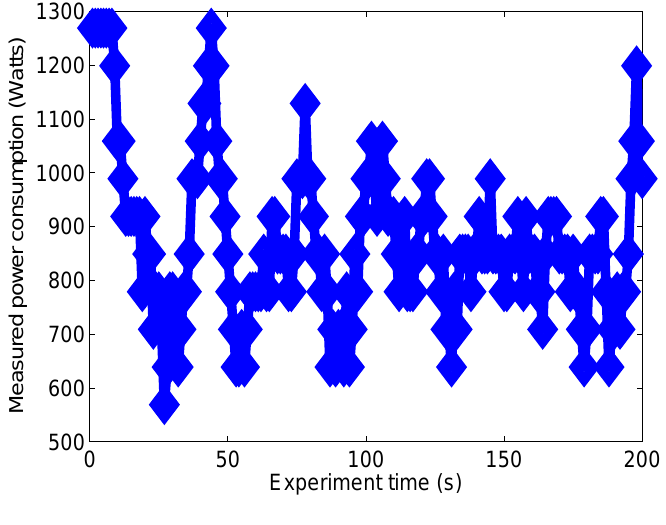
Figure 3. Power consumption measurements of experiment